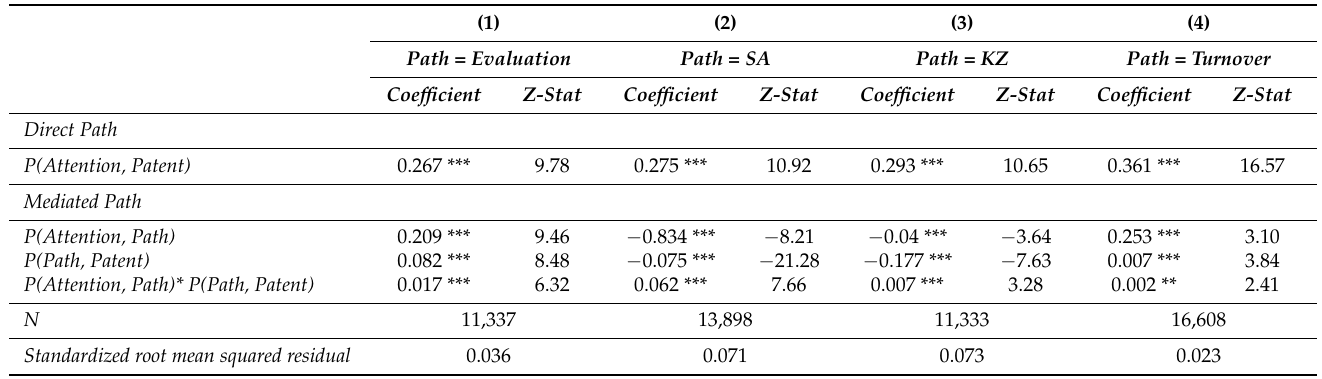
Table 4. Potential mechanisms